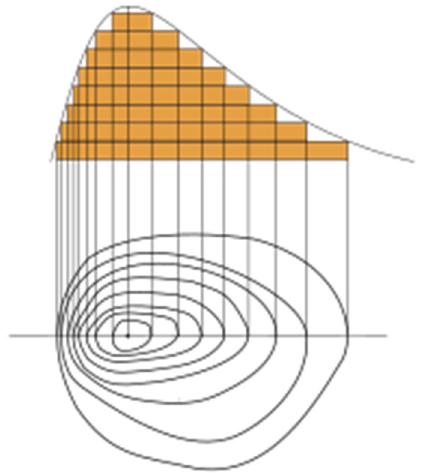
Figure 8. Example of isohypsum.